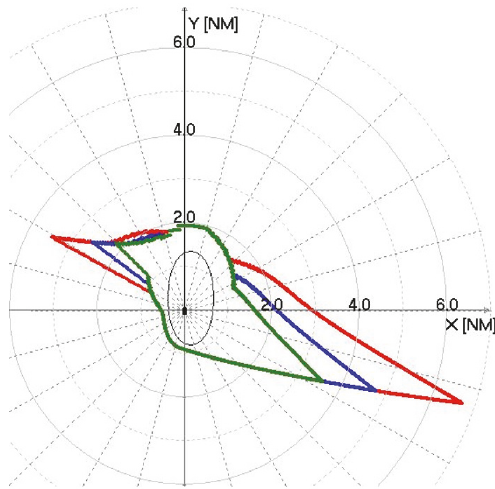
Figure 28: Action lines for stand-on encounterwith a target, whose true speed is 18 knots. Manoeuvres to starboard only are considered and they are additionally limited by risk of resonance. Wind of 20 [m/s] and wave from 10 ∘ (green), 350 ∘ (blue), and 335 ∘ (red) are assumed.